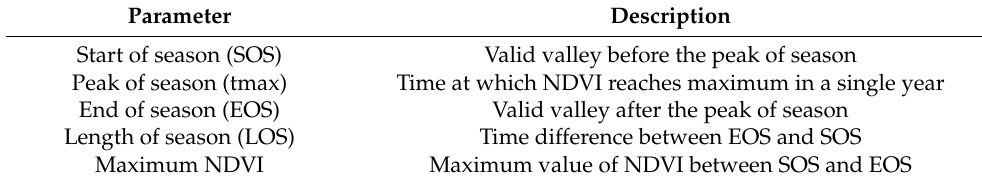
Figure 3. Time-series plot of NDVI from a crop in Abu Hammam, Syria, portrayed by Landsat 5 and 7 in 2000–2009 ( a ) and the zoomed version around 2008 ( b ). Circles represent the raw NDVI while the lines are for the harmonic fits. The phenology extraction for a specific year of interest is performed along the solid curve as shown in the bottom panel ( b ). Table 1. Extracted phenological